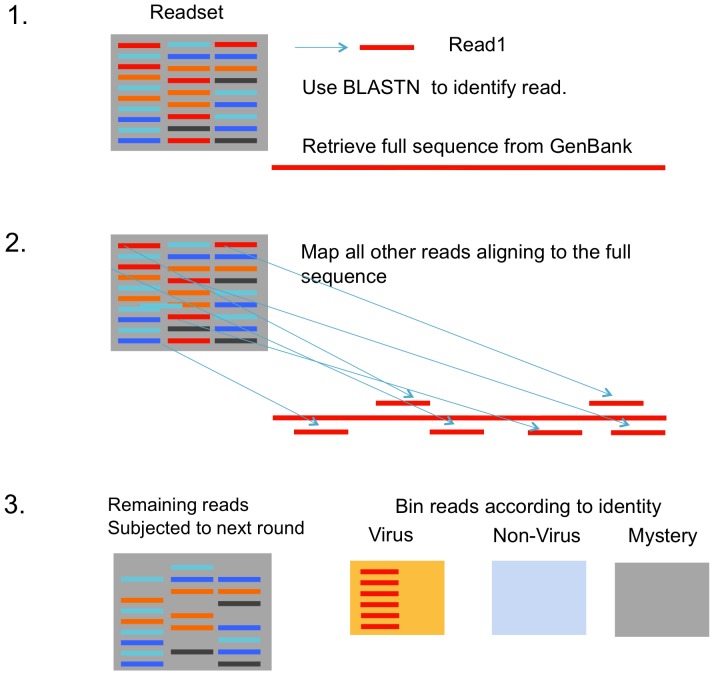
An overview of the SLIM read classification process.